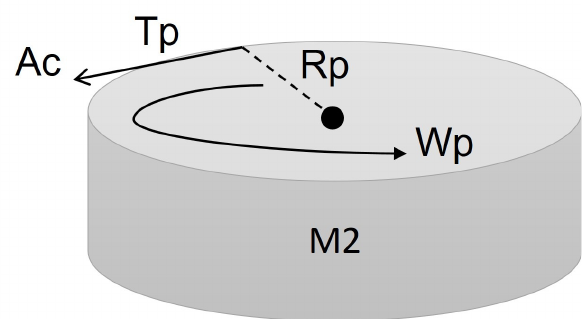
Figure 4. Pendulum schema reaction